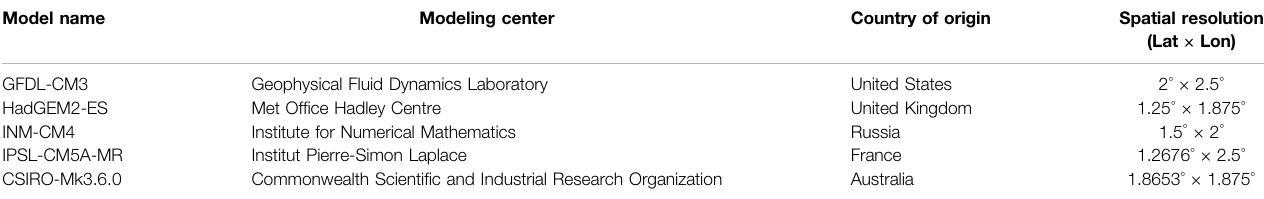
TABLE 1 | Characteristics of the fi ve GCMs used in this study for future